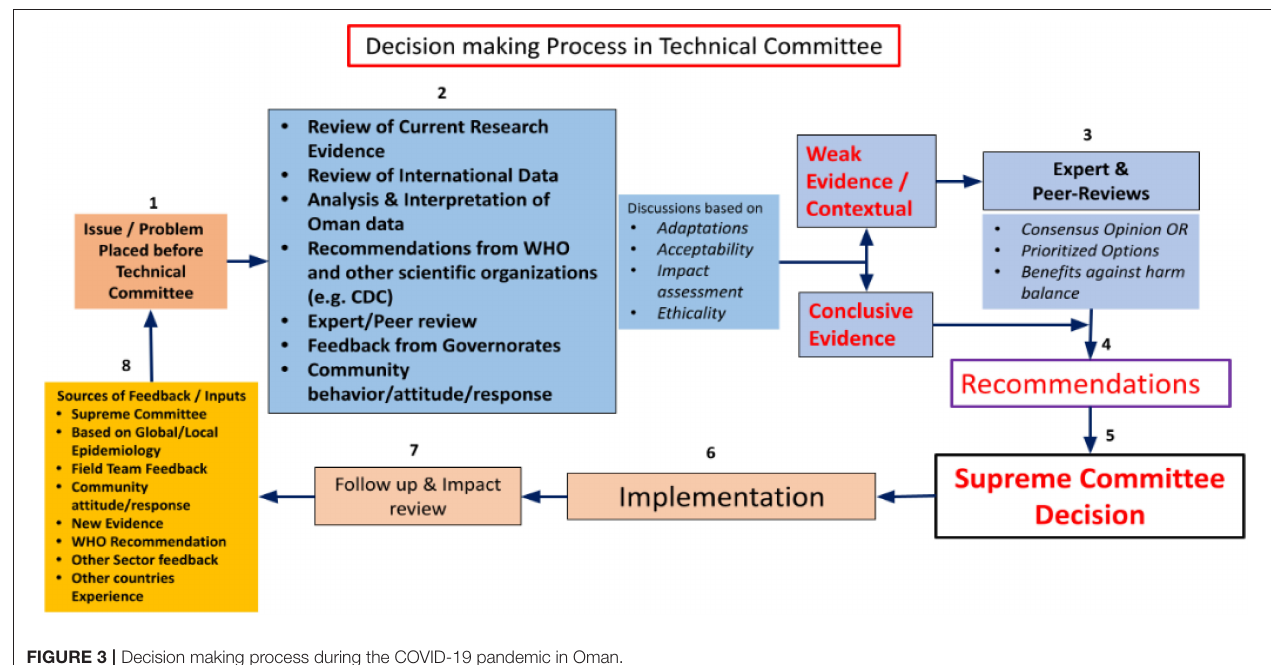
FIGURE 3 | Decision making process during the COVID-19 pandemic in Oman.